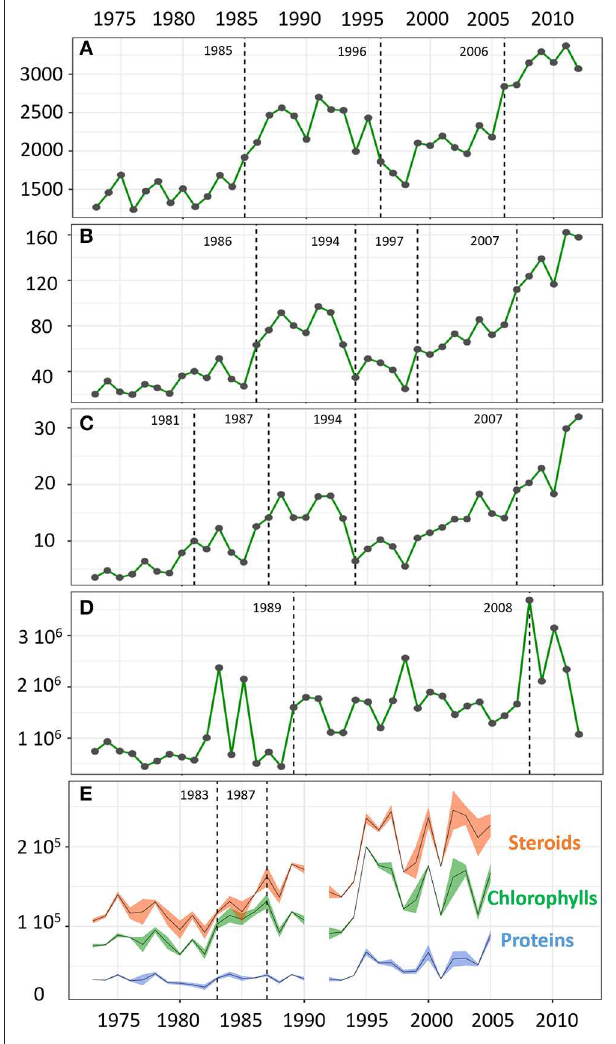
FIGURE 2 | Temporal changes in the OTU richness (A) , the transformed Shannon index (B) , and transformed Simpson index (C) , the abundance of Cyanobacteria (copies/g sed) over the period 1973–2012 (D) and the mean values of DM-AR normalized signal intensity for the biomarkers of algal OM (steroids, chlorophylls, proteins) with bands representing the standard deviations (over the period 1973–2005) (E) . Change points are indicated by dashed lines.